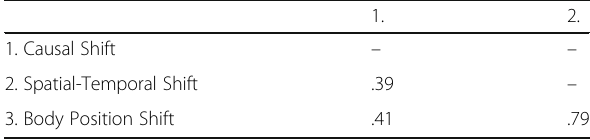
Table 3 Correlation matrix for situational analysis